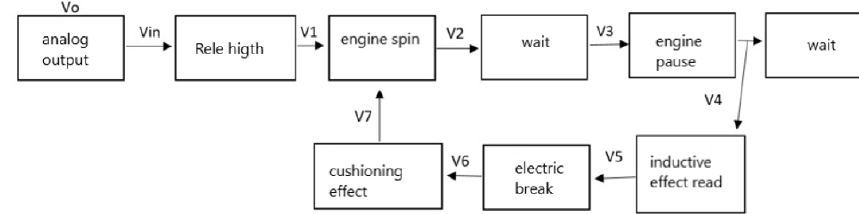
Figure 12. Primary and secondary pulse on stations for observing phase shift.